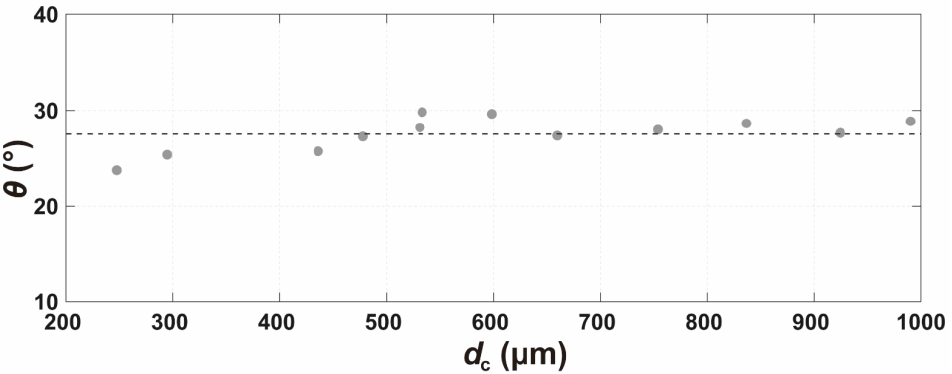
Figure 3. Contact angle θ as a function of contact diameter d c . The dotted line is the average value of the measured contact angles.